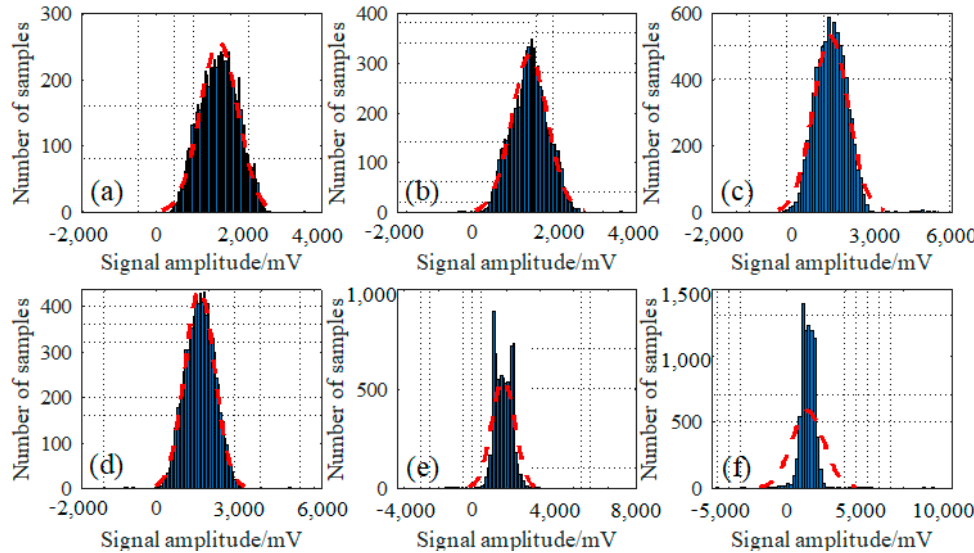
Figure 5. Probability density distribution of different wire rope defect signals: ( a ) for signals from defect 1; ( b ) for signals from defect 2; ( c ) for signals from defect 3; ( d ) for signals from defect 4; ( e ) for signals from defect 5; and ( f ) for signals from defect 6.